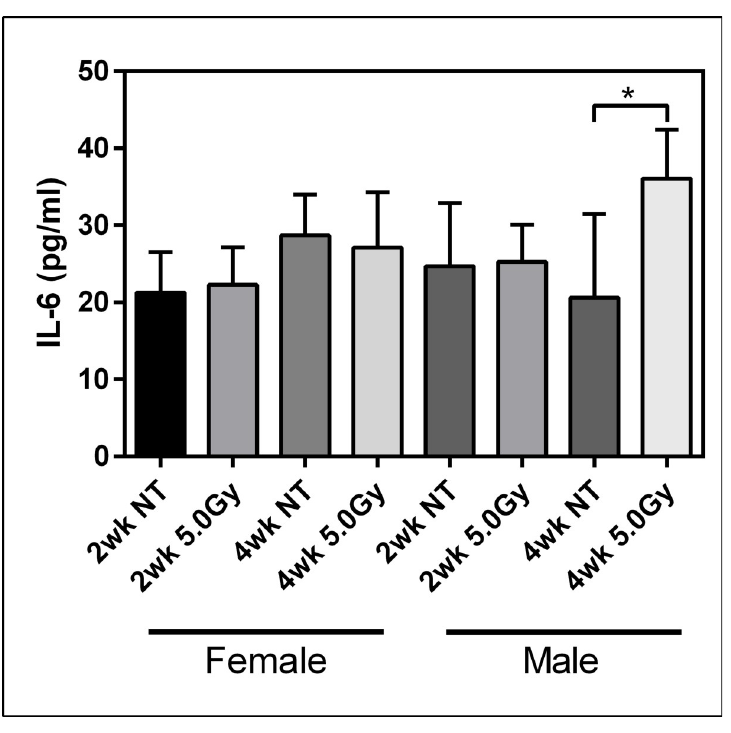
Fig 2. Inflammatory response following total body irradiation. Serum levels of IL-6 at two and four weeks after 5.0Gy total body irradiation. Error bars represent standard deviation. NT = no treatment; n = 3.